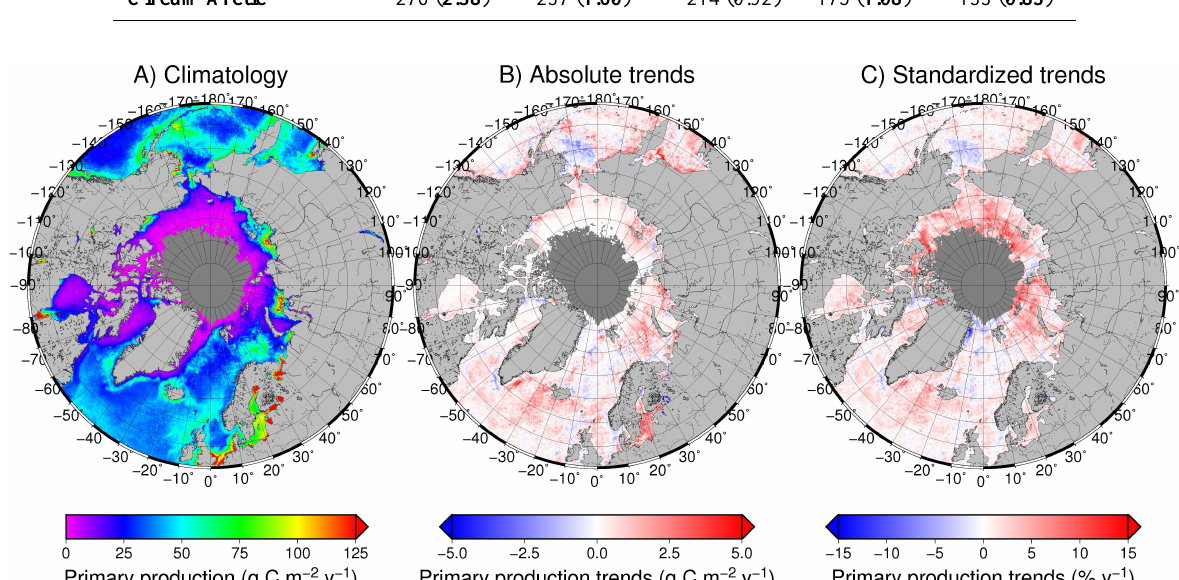
Fig. 3. (A) Climatological primary production rates for the 13yr SeaWiFS time series (1998–2010), (B) Absolute PP trends calculated using the TSA, and (C) the standardized PP trends (i.e. PP trends/climatological PP ·